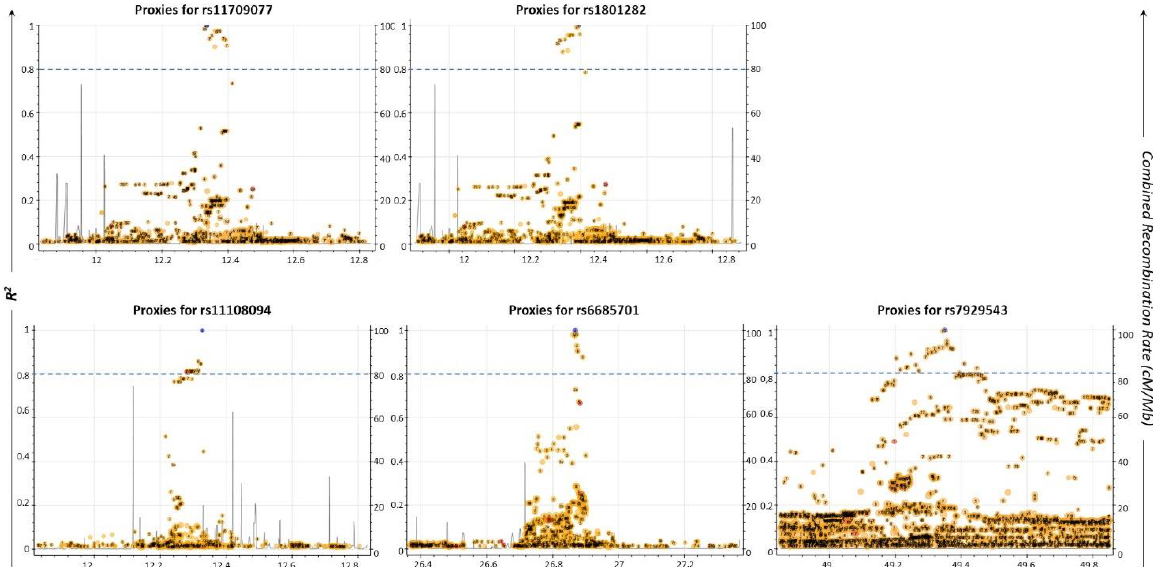
Figure 2. Regional LD plots of five commonly associated SNPs generated using the LDLink web tool (May 2021). Each dot represents the pairwise LD level between two individual SNPs. X-axis depicts the chromosomal coordinates. Left y-axis represents the pairwise R 2 value with the query variant; R 2 threshold greater than or equal to 0.8 was considered as a cut-off for selected proxies (blue dashed line). Right y-axis indicates the combined recombination rate (cM/Mb) from HapMap. Recombination rate is the rate at which the association between the two loci is changed. It combines the genetic (cM) and physical positions (Mb) of the marker by an interactive plot. Table 3. Summary of the proxy SNPs (R 2 ≥ 0.8) for each common AML/T2D susceptibility SNP, along with their chromo- somal location, correlated alleles and associated genes, as collected from LDLink tool [24] (May 2021).